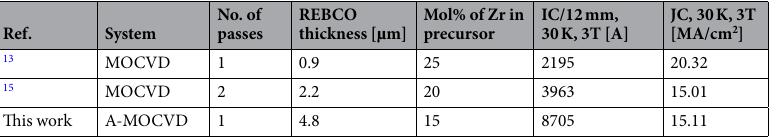
Table 1. Comparison of performance and deposition details between this work done using A-MOCVD and previous results obtained using conventional MOCVD.